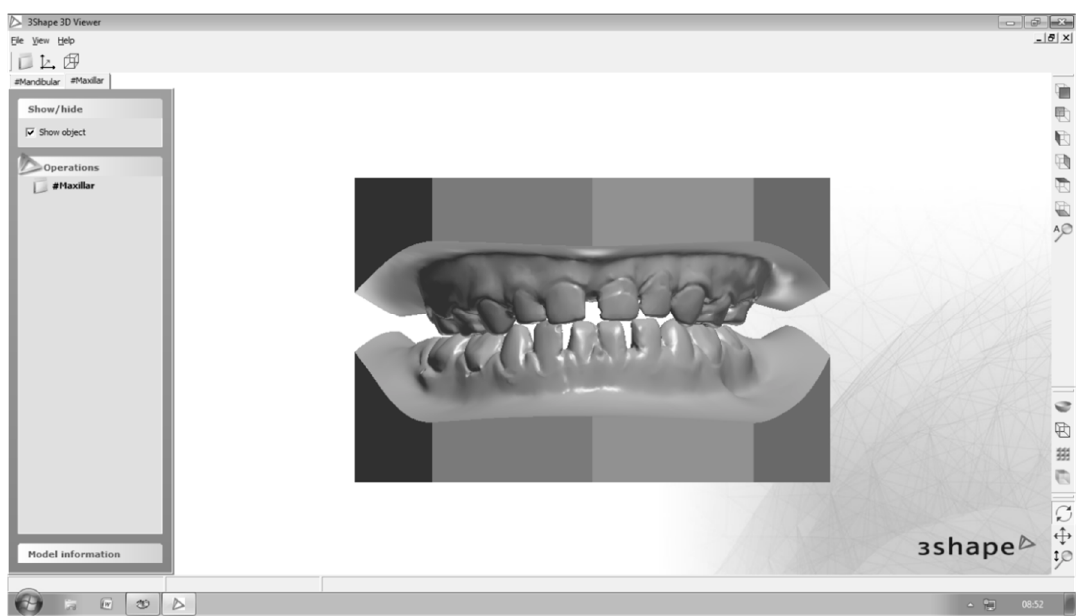
Figure 4. Front view of digital model.